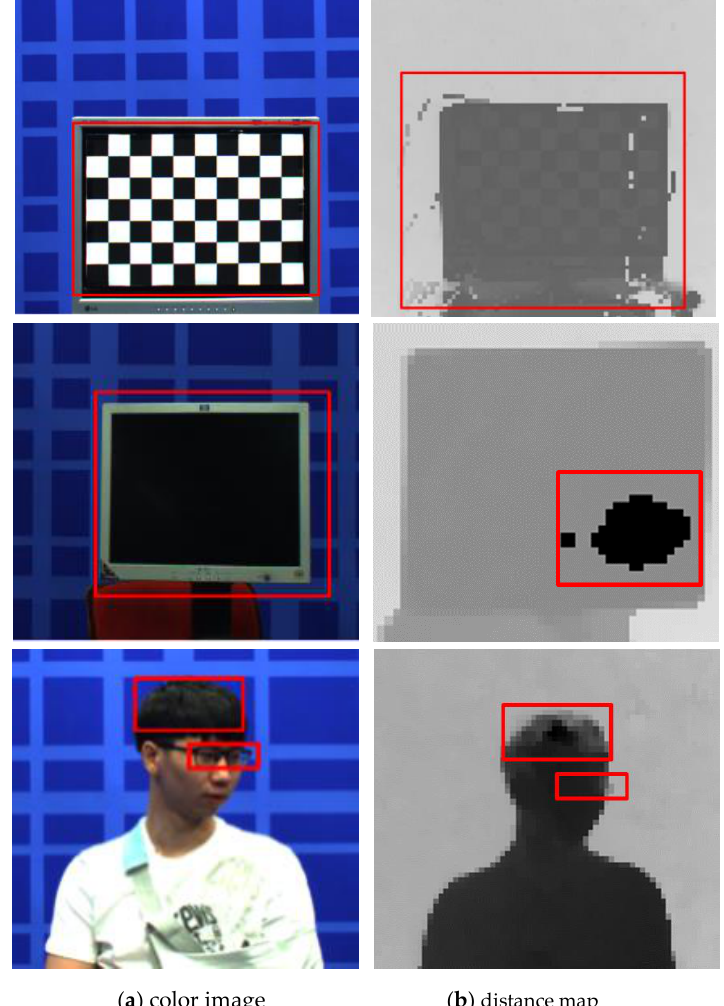
Figure 10. Examples of shiny and dark surfaces. First row represents chessboard pattern, second row shows a monitor, and third row shows hair and glasses.